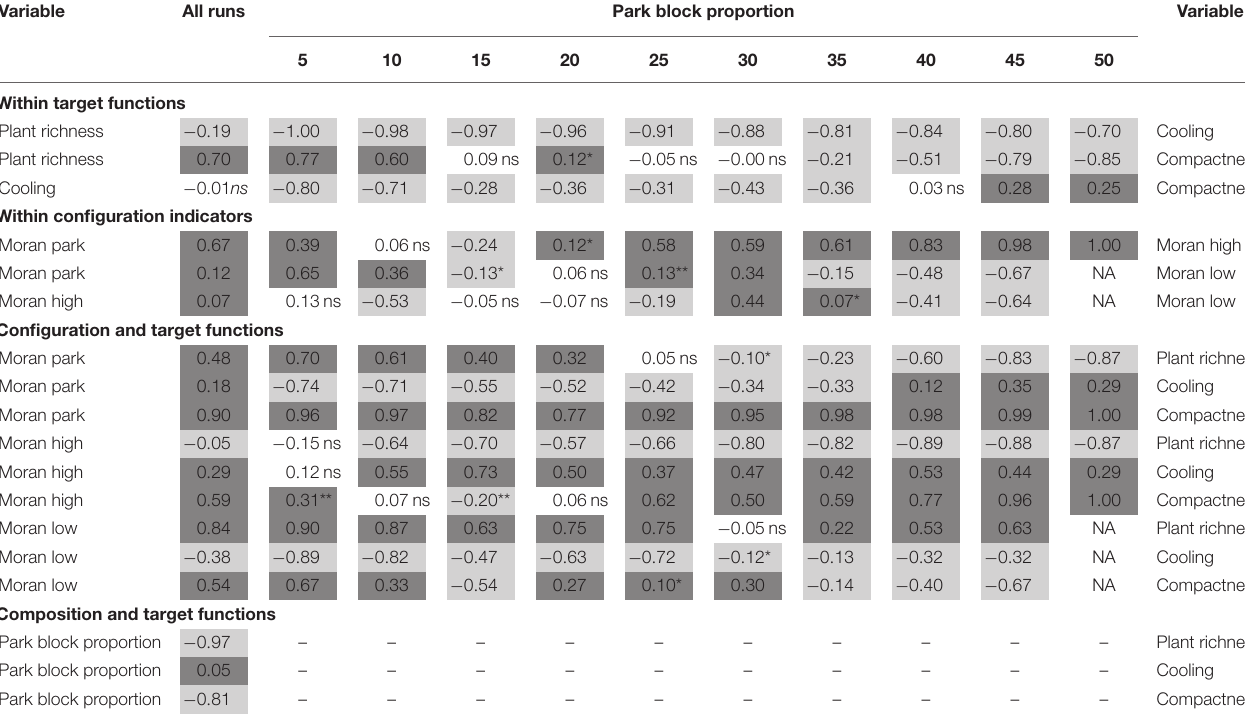
FIGURE 3 | Front of non-dominated solutions for an example composition of 20% park blocks, 20% high- density, and 60% low-density built-up blocks and maps for solutions with maximum values for cooling (1), compactness (2), and biodiversity (3). The maps indicate the location of parks in white, low-density blocks in gray, and high-density blocks in black. TABLE 5 | Correlation matrix for all optimization runs (varying park block proportions) based on Spearman’s rank correlations among the three target functions.